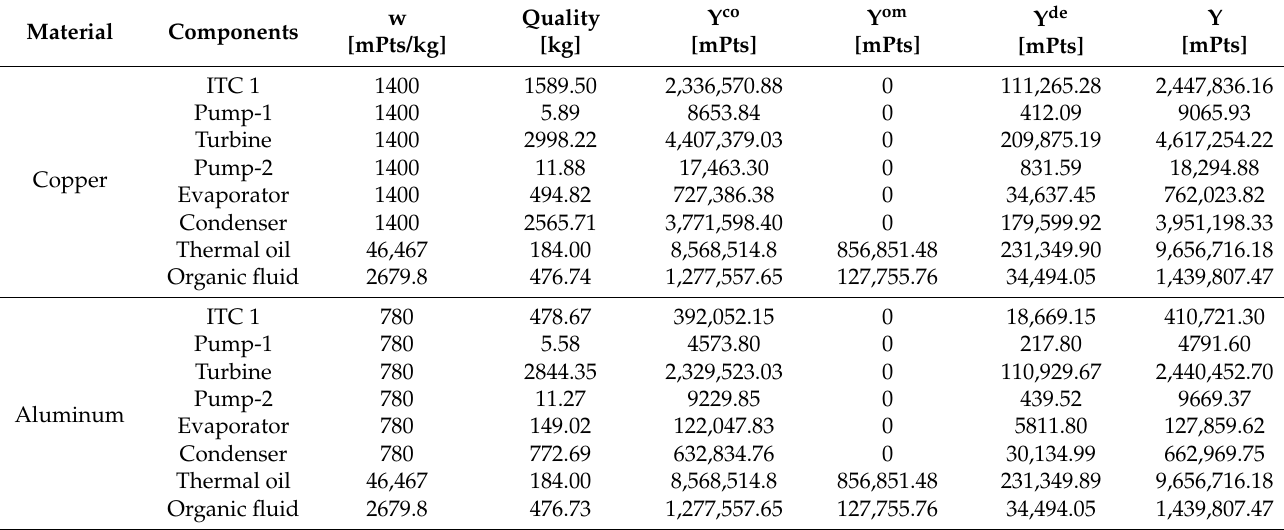
Table 16. Life cycle analysis results for copper and